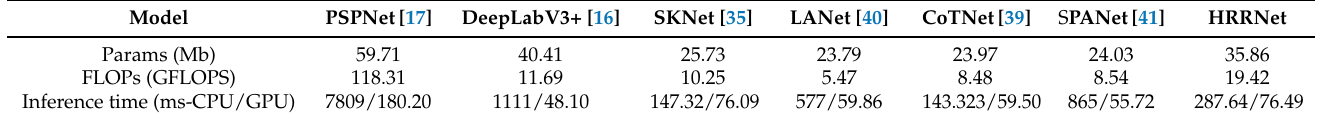
Table 7. Complexity metrics for various models. (The input is the 3 × 256 ×